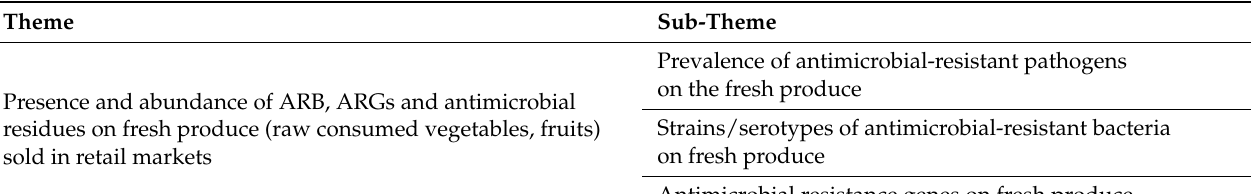
Table 2. Framework for data